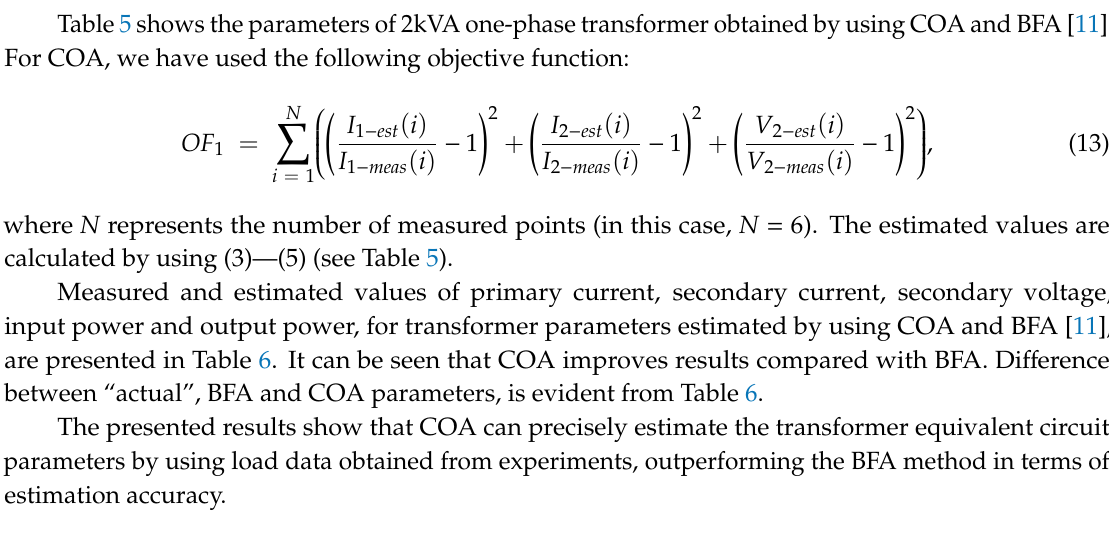
Table 5. Parameter values for 15kVA